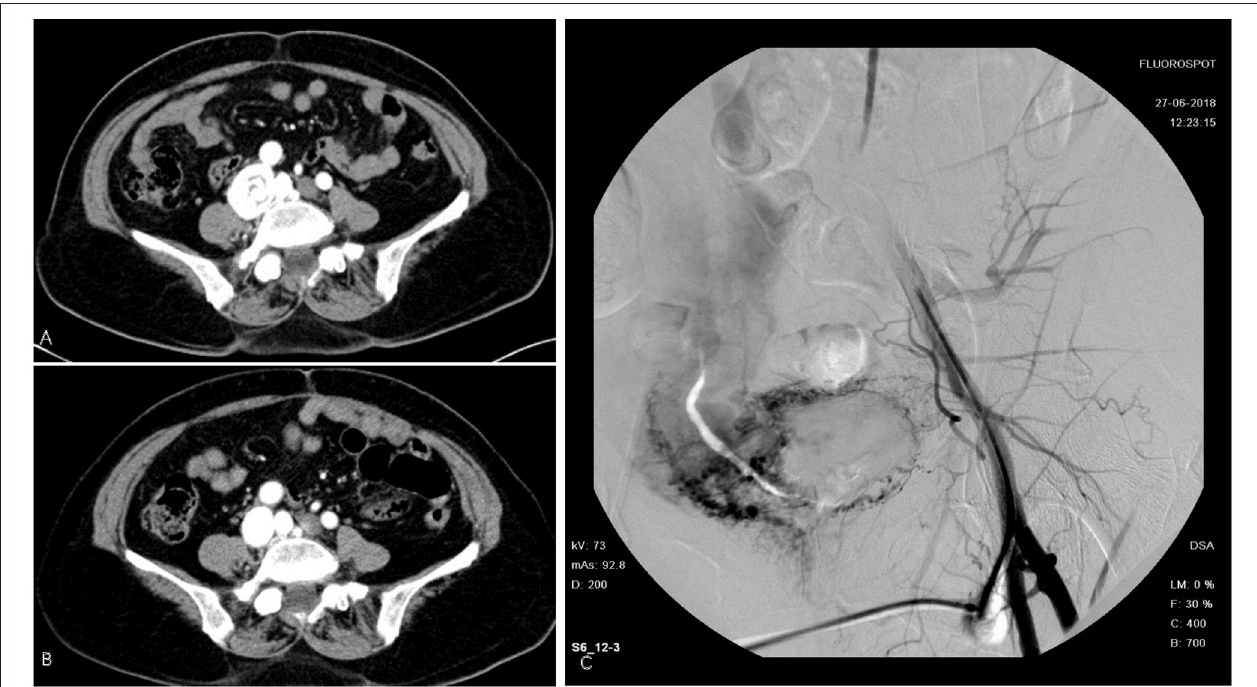
FIGURE 1 | Intravenous leiomyomatosis (IVL) in inferior vena cava (IVC). (A) Cord like tumor in IVC. (B) Tumor removed surgically. (C) Digital subtraction angiography (DSA) demonstrated a contrast agent entering the right iliac vein and IVC through vascular